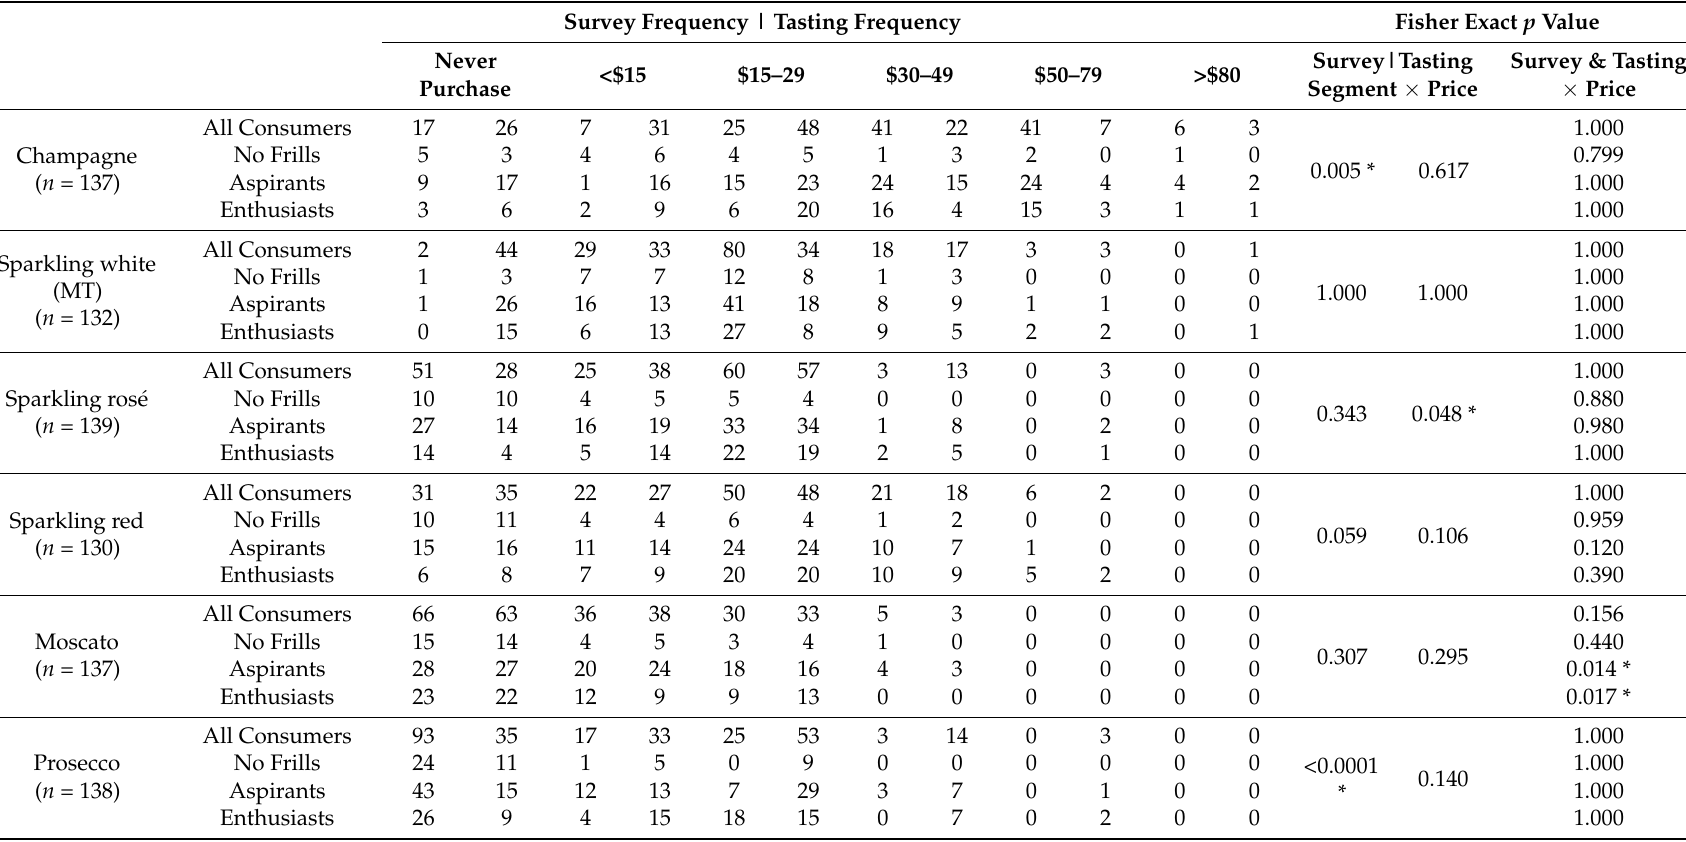
Table 9. Typical spend by consumers and Fine Wine Instrument consumer segments for different sparkling wine styles (as Australian dollars per 750 mL